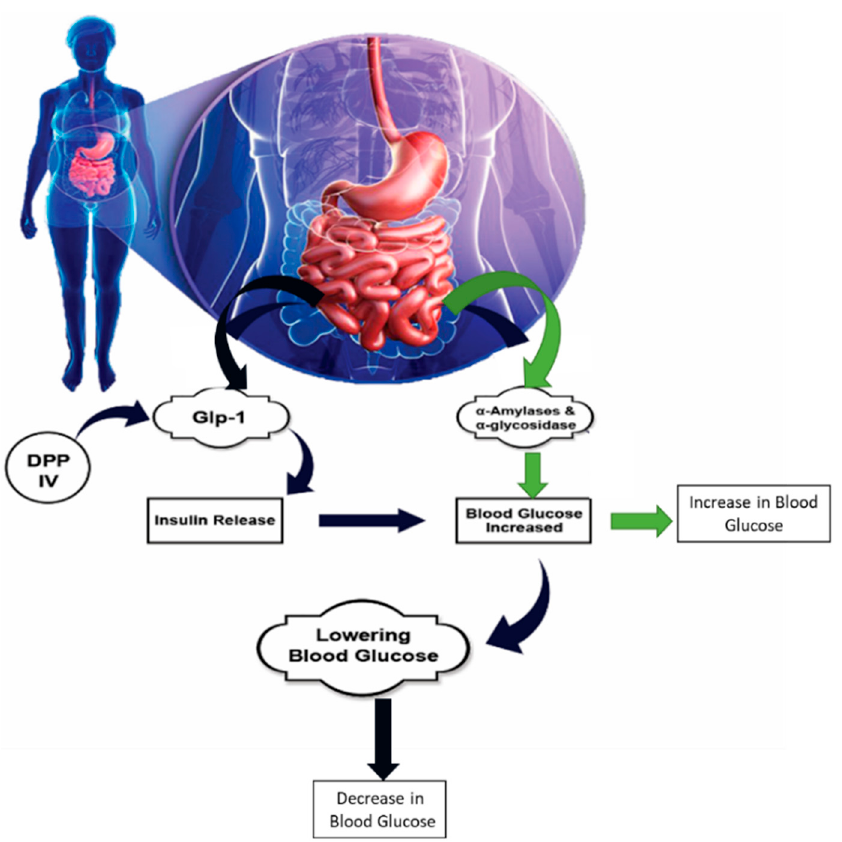
Figure 6. Bioactive peptides, inhibit key enzymes involved in diabetes—DPP IV, α -amylase, and α -glucosidase, which results in the antidiabetic activity mainly by promoting insulin signaling and the AMPK signaling pathway .